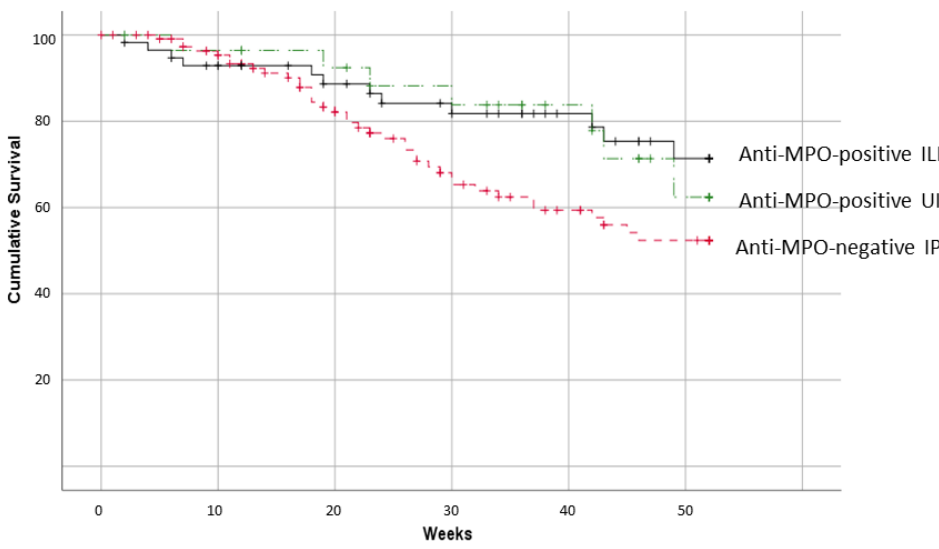
Figure 2. Fifty-two-week survival of patients with anti-MPO, anti-MPO-UIP, and